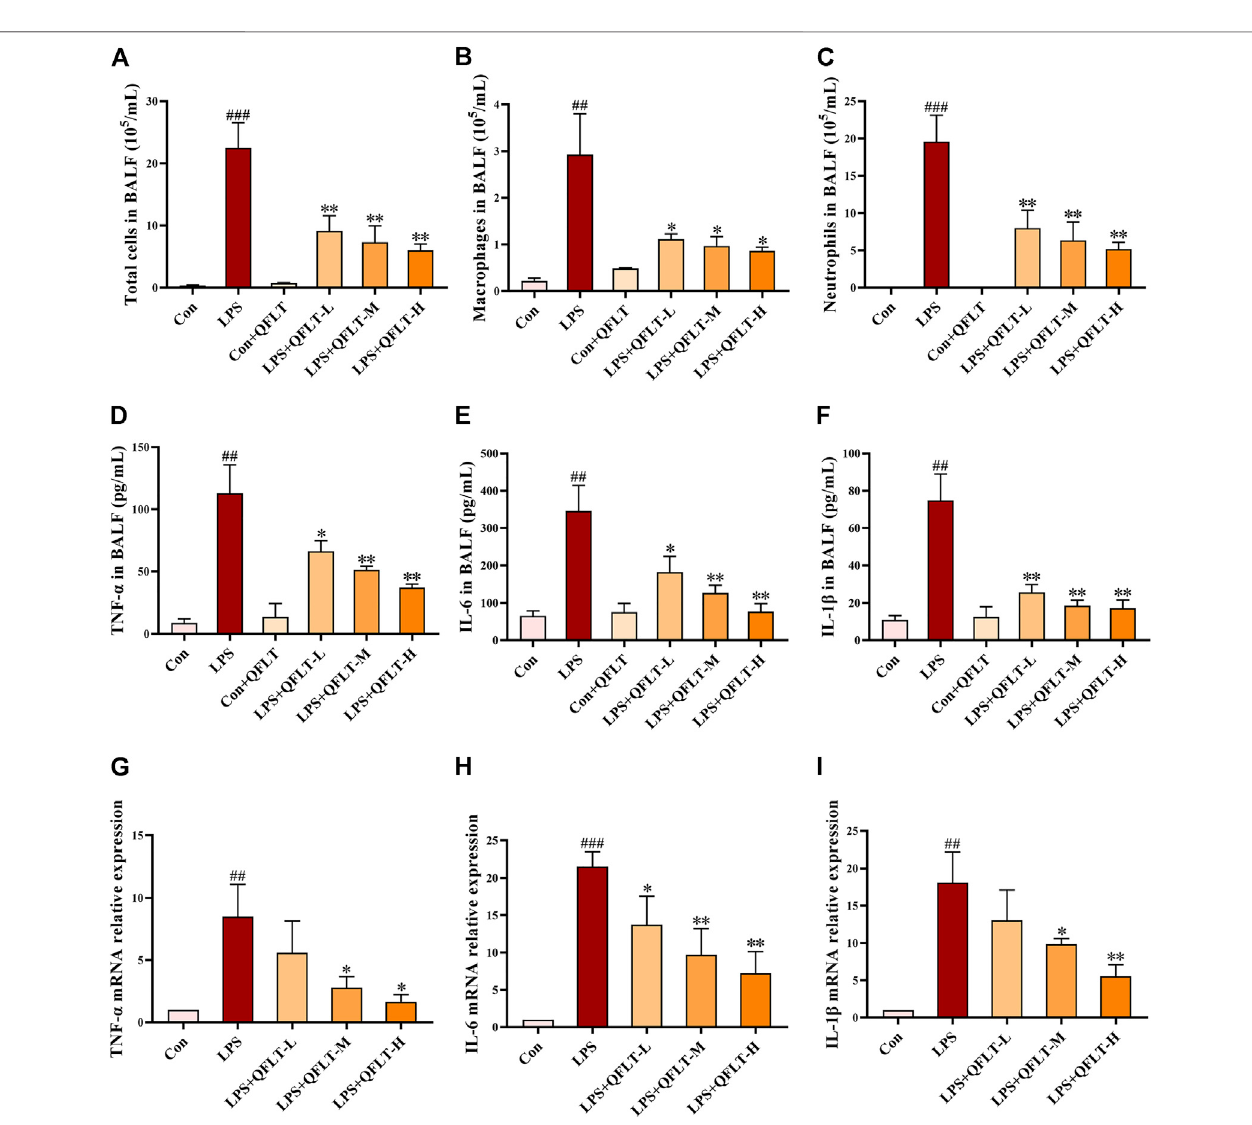
FIGURE 8 | Effects of QFLT treatment on in fl ammatory levels in vivo . (A – C) After staining with Wright – Giemsa solution, the number of total cells, neutrophils, and macrophages in BALF were counted using light microscopy. (D – F) Thelevels ofTNF- α , IL-1 β and IL-6 inBALFweresigni fi cantlyinhibited byQFLT. (G – I) Levels ofTNF- α , IL-1 β and IL -6 in LPS-challenged mice lung tissue measured by qPCR. Effects of QFLT treatment on levels of oxidation product in vivo . Data were expressed as the mean ± SD ( n = 3). ## p < 0.01 vs. the control group; * p < 0.05 vs. the LPS group.